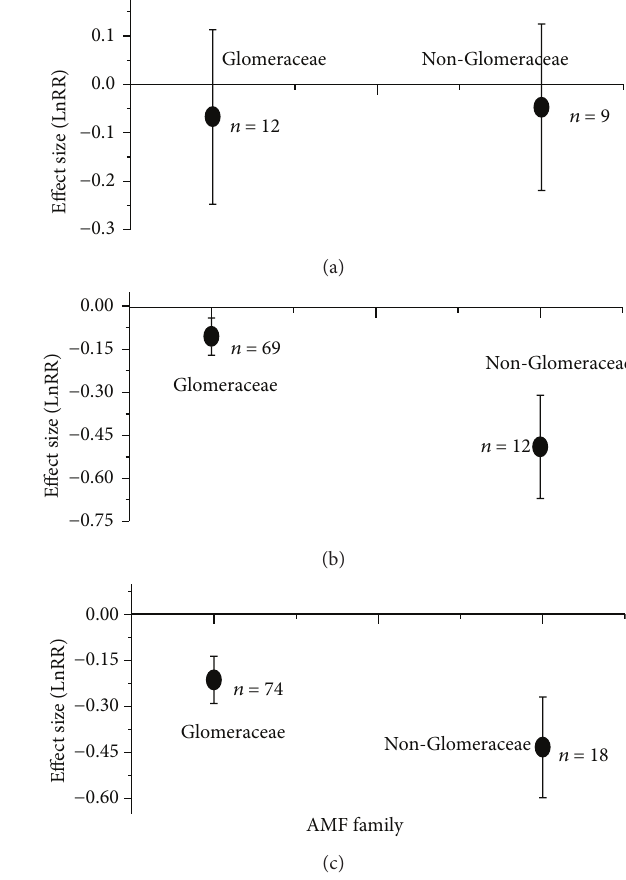
Figure 4: Effect size ( mean ±95 % CI ) of biotic stressors of plants to AMF: (a) herbivores; (b) nematodes; (c) fungal pathogens.